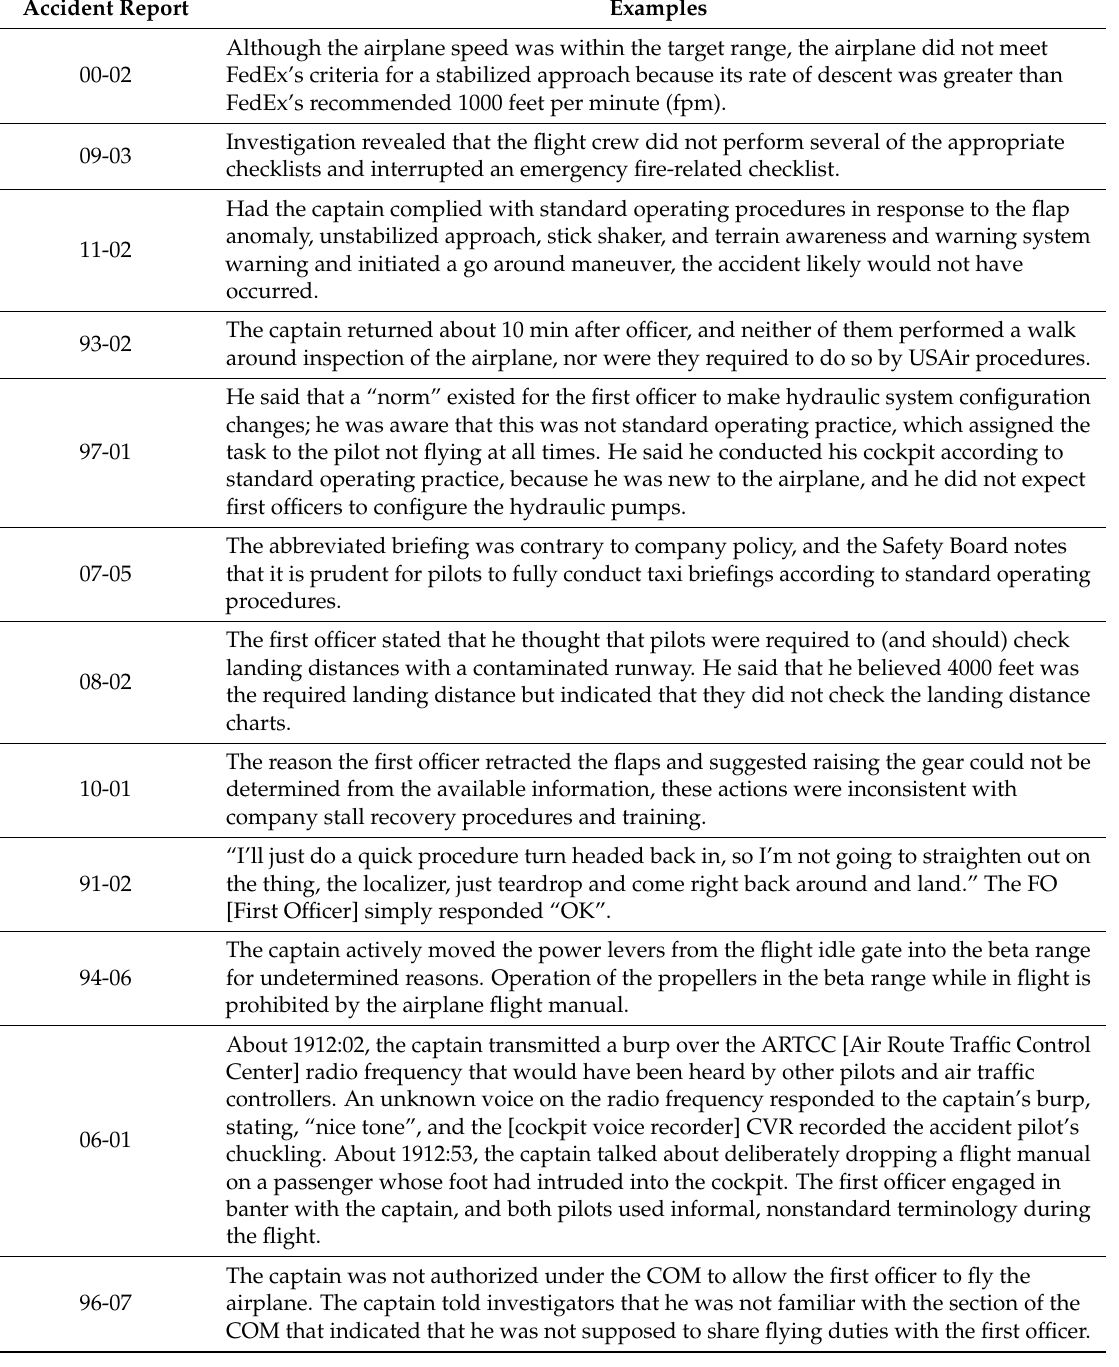
Table 4. Examples of Neglect of Flight Planning, Preflight Inspections, and Checklists. Accident